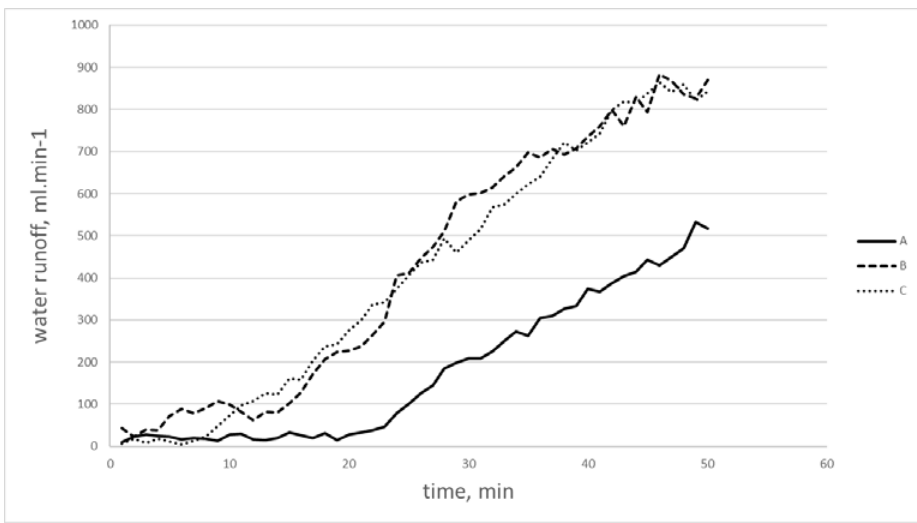
Figure 9. Intensity of water runoff measured in three locations during the simulated rain with the intensity of 1300 mL min −1 : (A) no traffic area; (B) single pass area; (C) multiple pass/permanent tramline area.